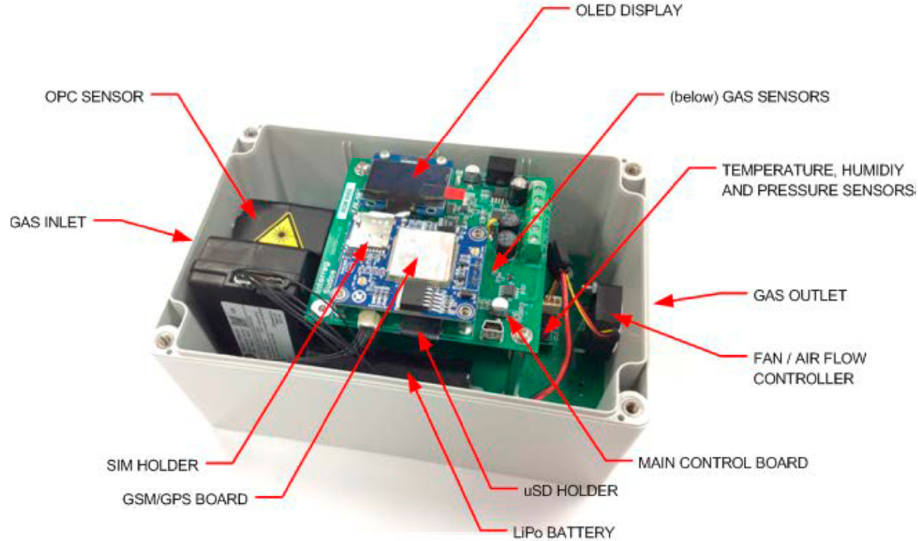
Figure 2. Device inside protective